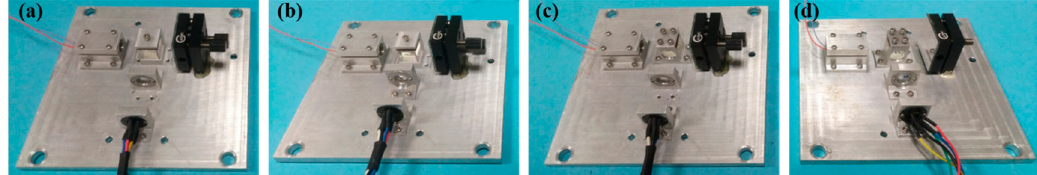
Figure 8. Photos of the ( a ) original sensor, ( b ) optimized sensor excluding the PBS mount, ( c ) optimized sensor excluding the FL mount, and ( d ) optimized angle sensor.